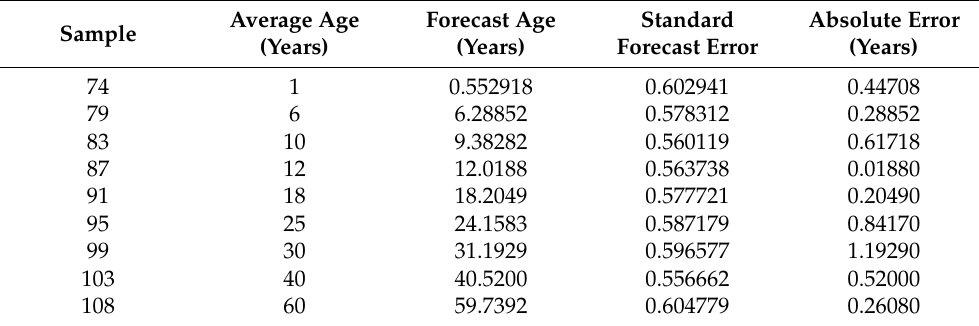
Table 14. Validation of the model PC5 with nine of the analyzed Palo Cortado Sherry wine